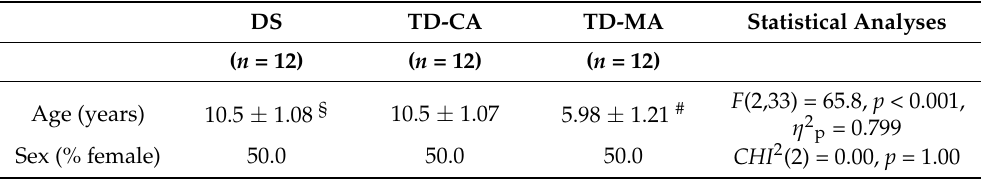
Table 1. Age and sex distribution of children with DS, TD-CA, and TD-MA controls, including mean values (standard deviation).